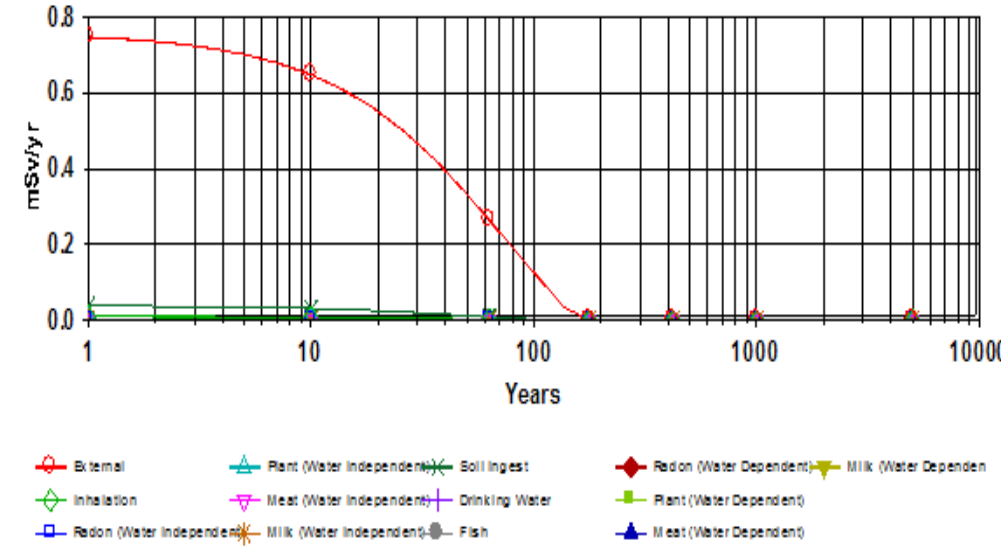
Fig.6: The contribution pathways of all nuclide to total dose of area (A) for suburban resident